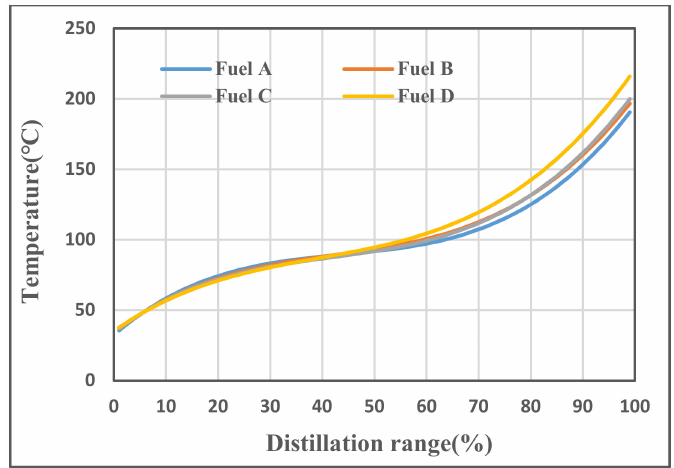
Figure 5. Distillation curve.